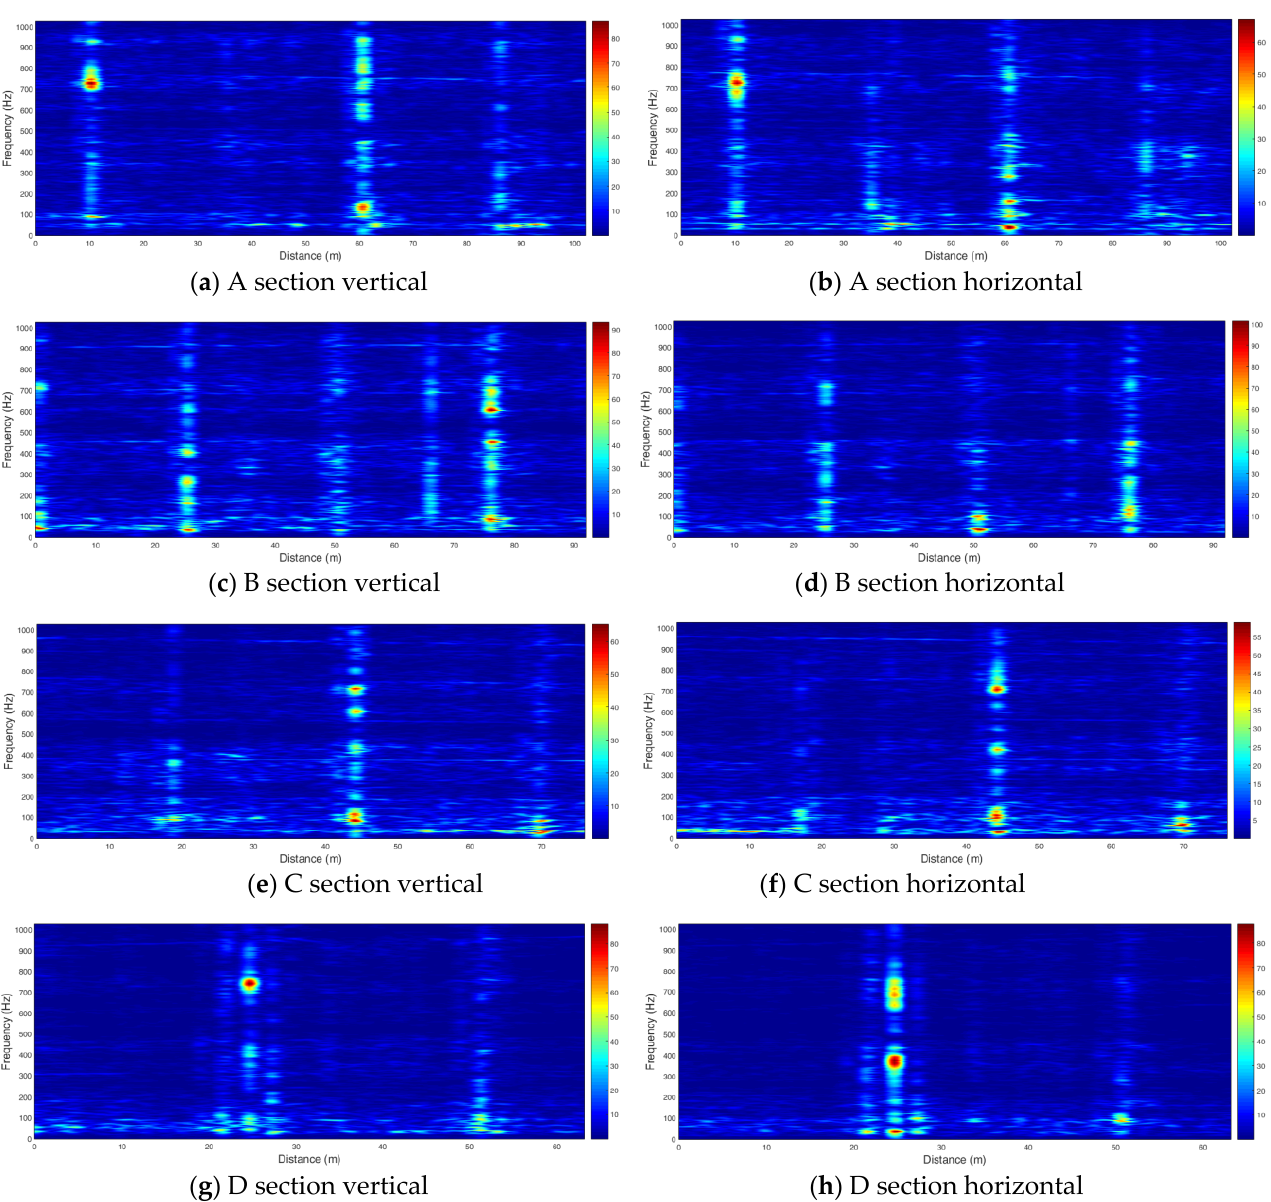
Figure 6. Vertical and horizontal